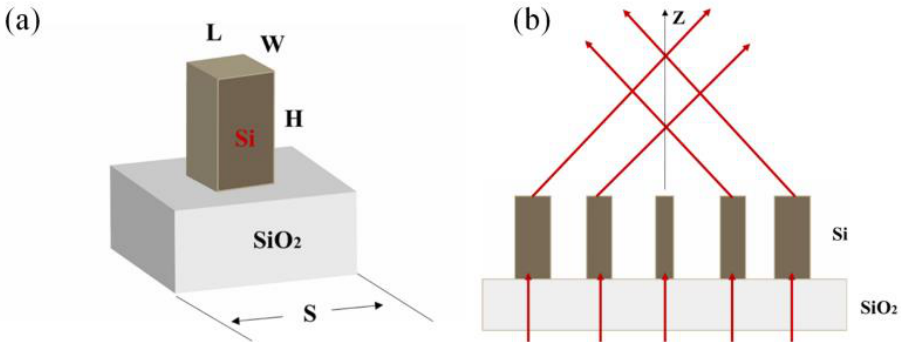
Figure 1. Schematic of Bessel beam generator. ( a ) Three-dimensional unit cell structure. ( b ) Excitation Bessel beams by an array.